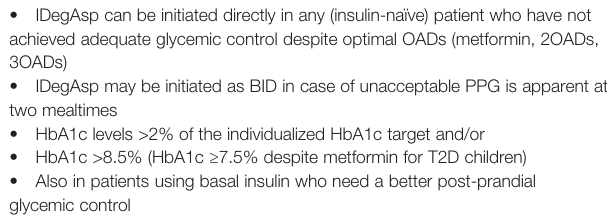
TABLE 2 | Expert Panel Recommendation 2: Insulin-naïve